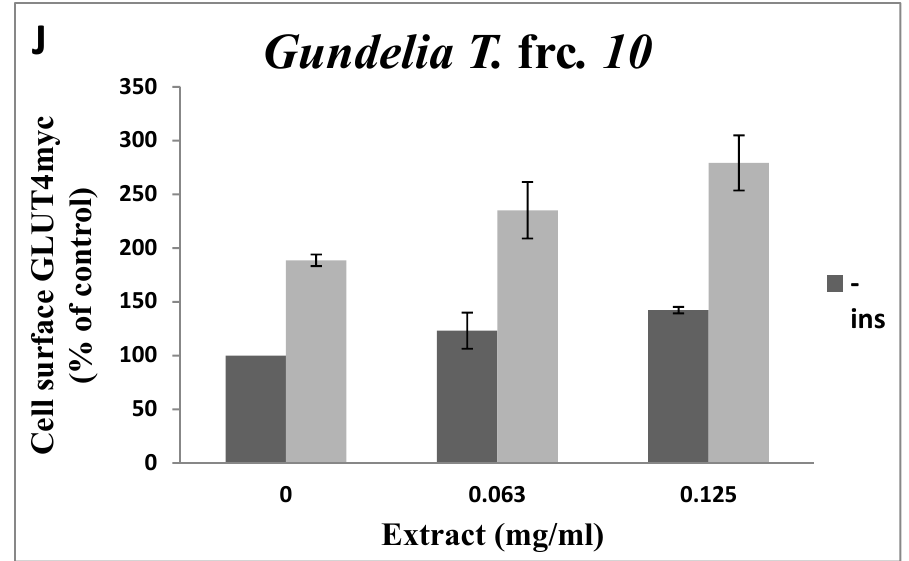
Figure 3. GLUT4 translocation to the plasma membrane. For the evaluation of the GLUT4 L6-GLUT4myc, cells (150,000 cell/well) were exposed to GT fractions ( A – J ) for 20 h. Serum depleted cells were treated without ( − ) or with (+)1 μ M insulin for 20 min at 37 °C and surface myc -tagged GLUT4 density was quantified using the antibody coupled colorimetric assay. Values given represent means ± SEM (relative to untreated control cells) of three independent experiments carried out in triplicates.